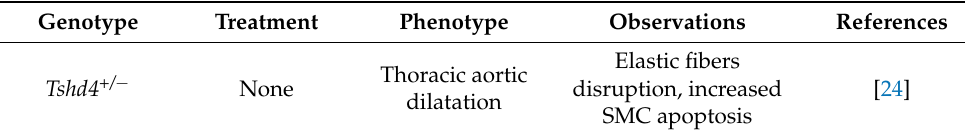
Table 1. Adamts associated with rodent phenotype